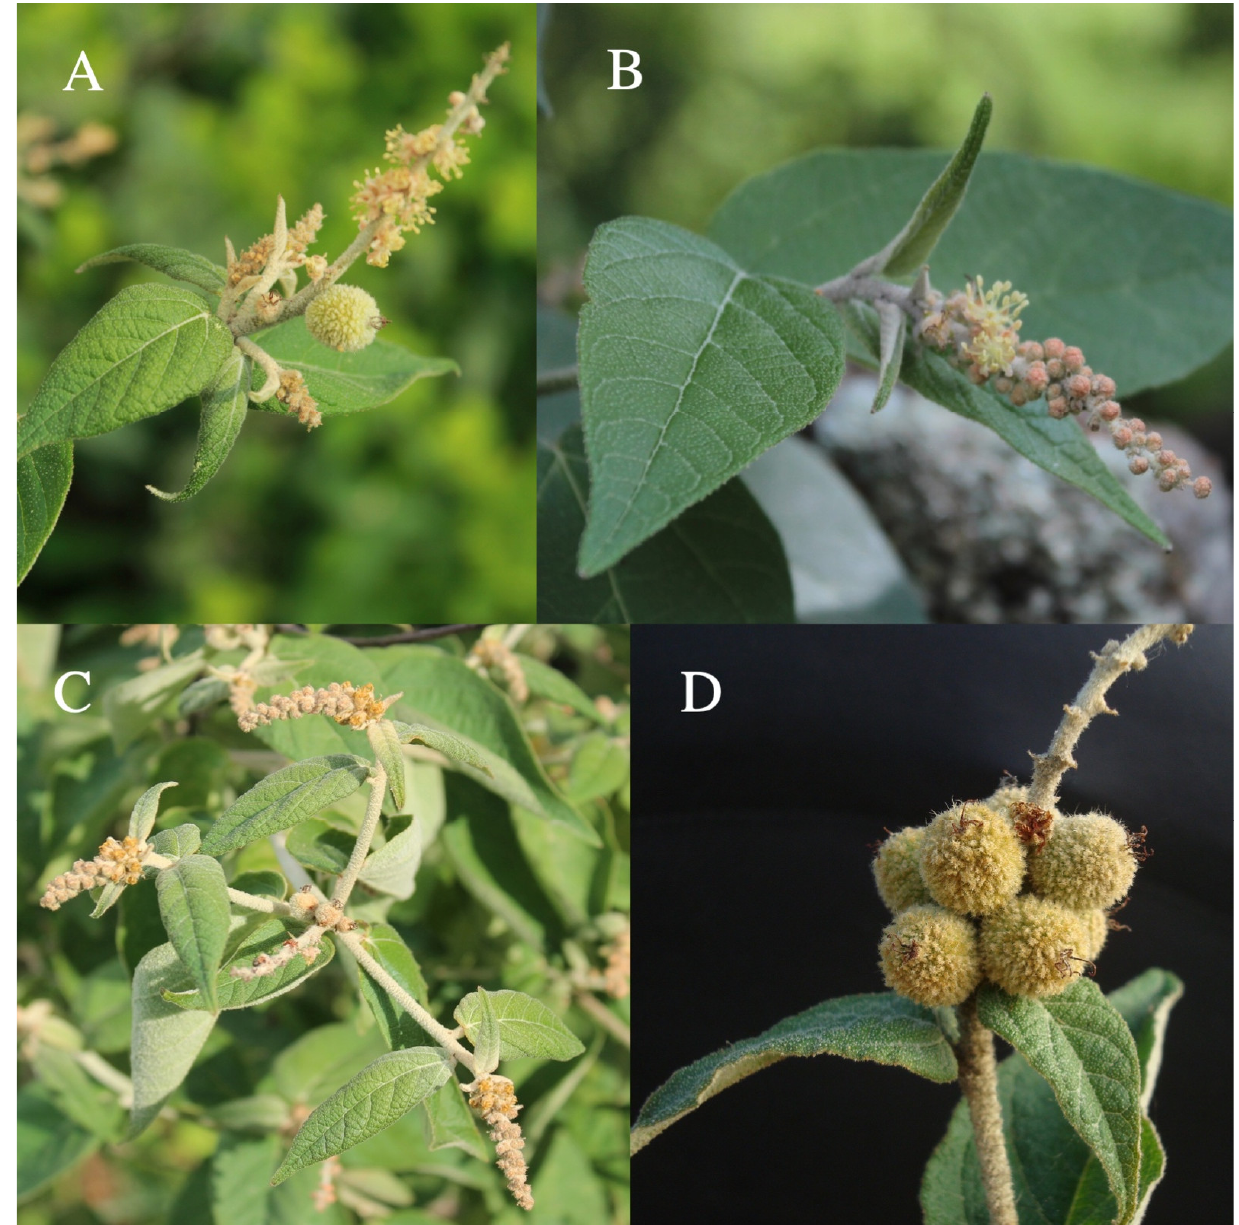
Figure A15. Croton sphaerocarpus. ( A – C ) Branchlets with inflorescences. ( D ) Fruits. ( A – C ) photographed by Nancy Izquierdo and used with permission; ( D ) photographed by Guadalupe Cornejo and used with